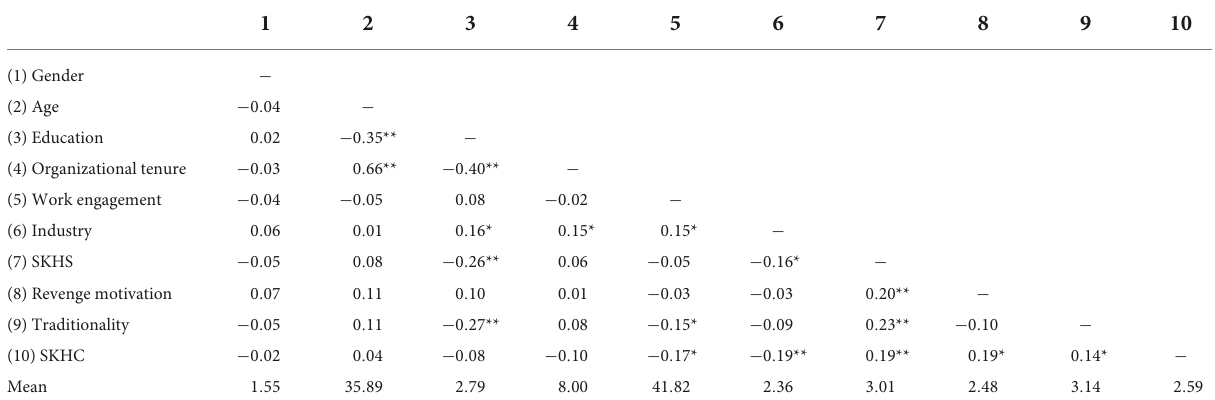
TABLE 2 Means, standard deviations, and inter-correlations.